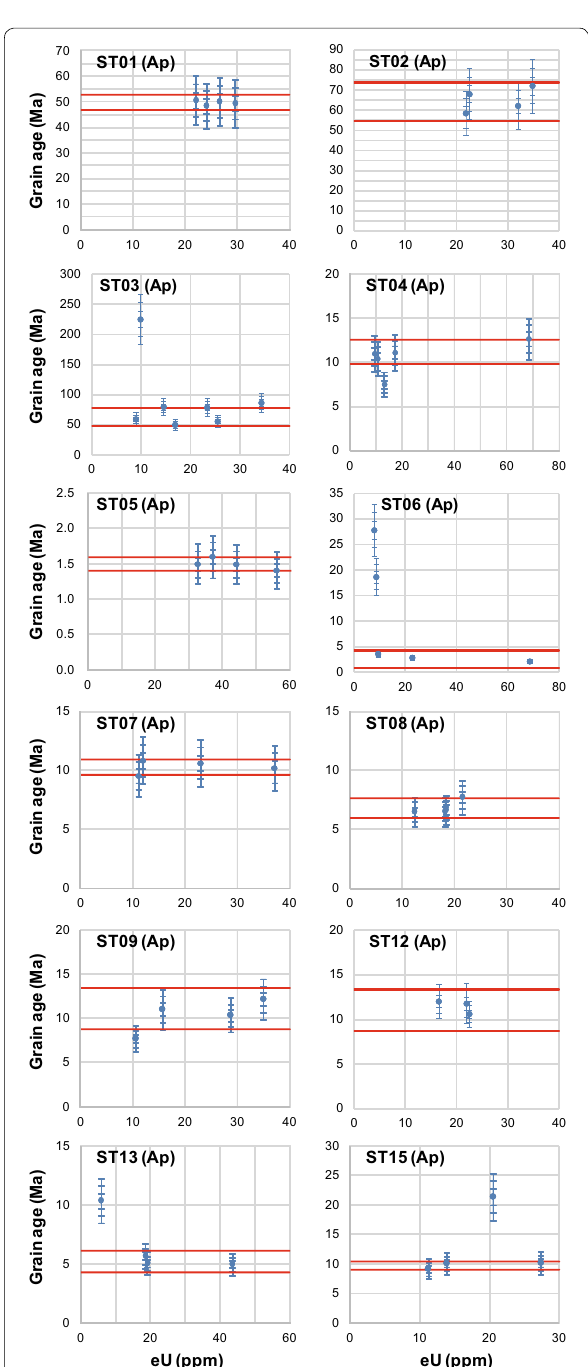
Fig. 3 Effective uranium (eU) versus (U–Th–Sm)/He grain age of apatite. The vertical error bars denote the The two horizontal red lines indicate the weighted mean age confidence interval (CI) and